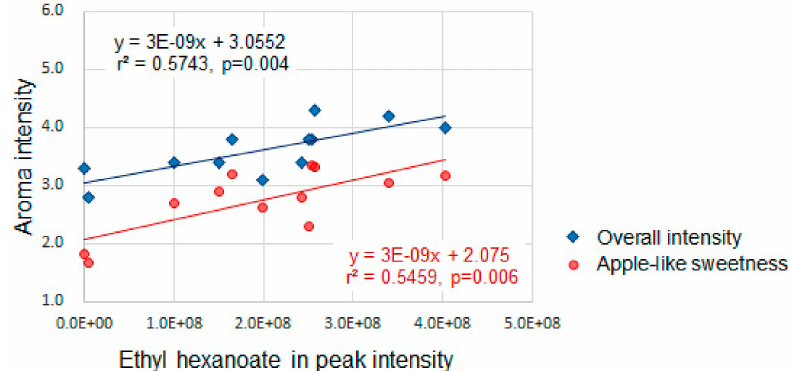
Figure 2. Ethyl hexanoate and aroma intensity in ester-enhanced ‘Fuji’ by incubation with ethanol mixture. Ethyl hexanoate is shown as a representative of ethyl esters because major ethyl esters of ‘Fuji’ correlate with one another in their peak